Question: What kind of plot is shown here?
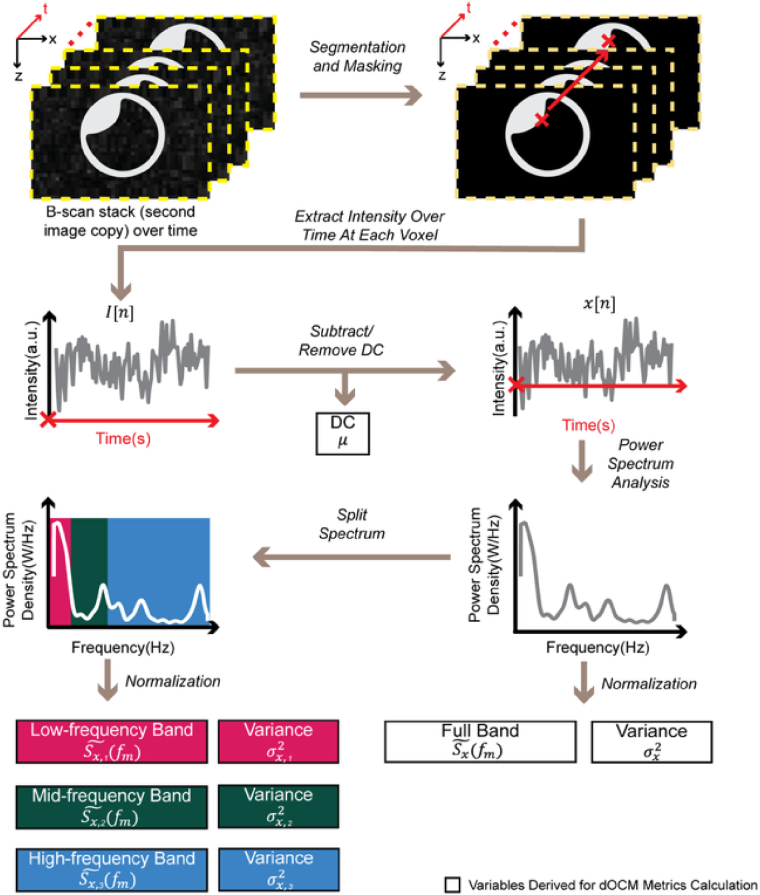
Answer: line